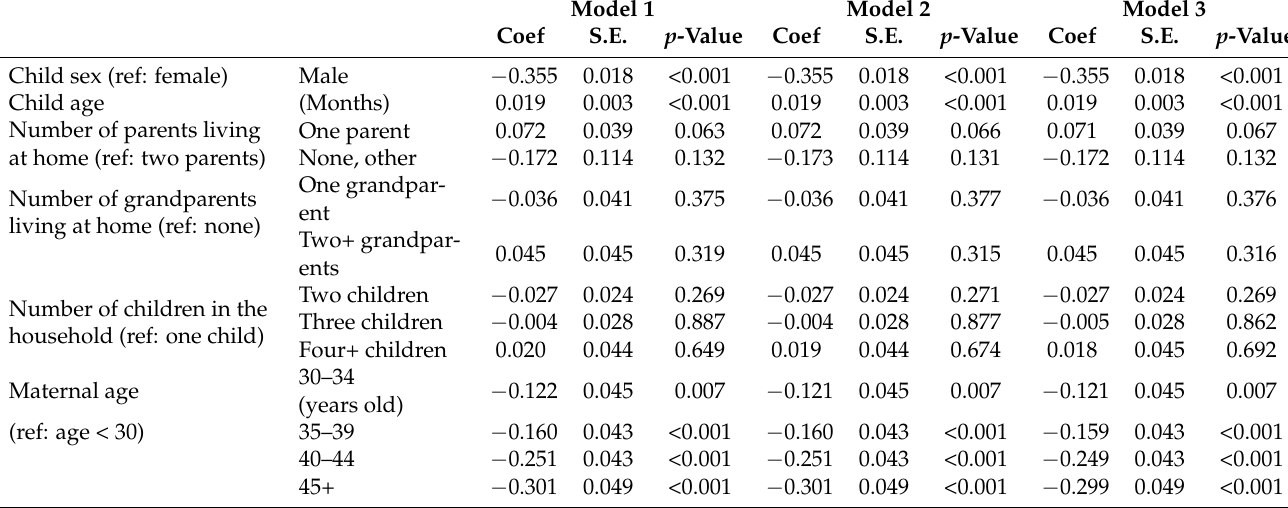
Table 4. Relationship between multiple types of poverty and children’s prosocial behavior (SDQ